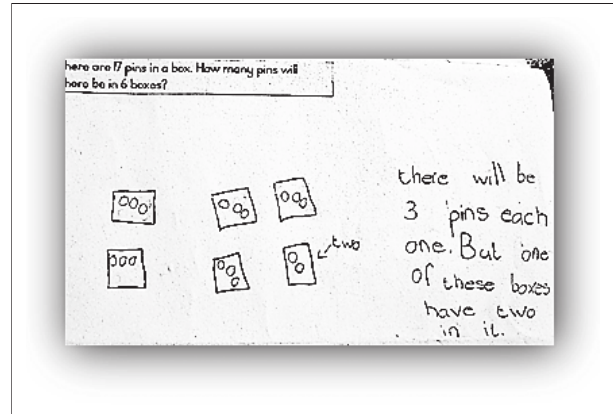
FIGURE 8: Gemma (Pre-test).